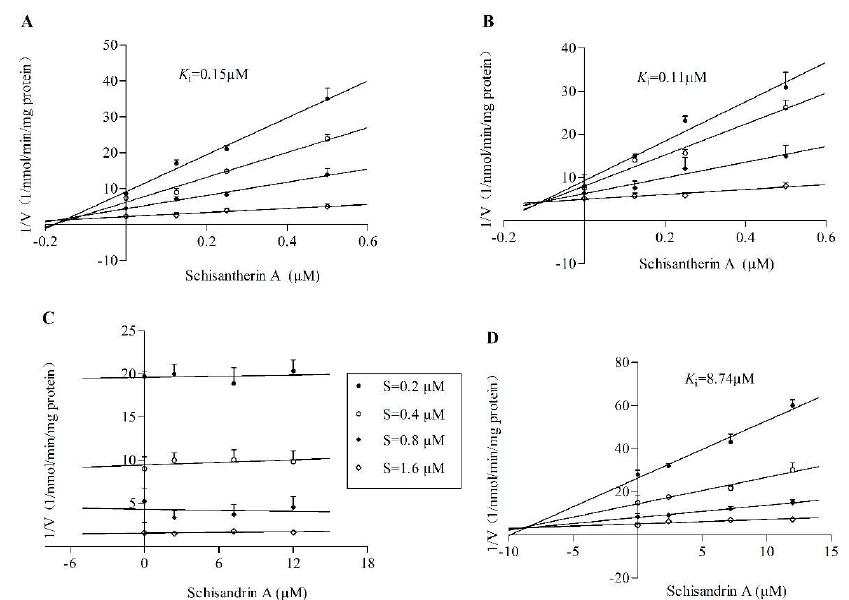
Figure 2. Dixon plots of STA on CYP3A4 ( A ) and CYP3A5 ( B ) of tacrolimus activity metabolism; Dixon plots of SIA on CYP3A4 ( C ) and CYP3A5 ( D ) tacrolimus activity metabolism. Different concentrations of STA (0, 0.125, 0.25 or 0.5 µ M), SIA (0, 2.4, 7.2 or 12 µ M) and tacrolimus (0.2, 0.4, 0.8 or 1.6 µ M) were used. Each incubation was conducted in triplicate (mean values and standard variation (SD) values are listed in Table S1).